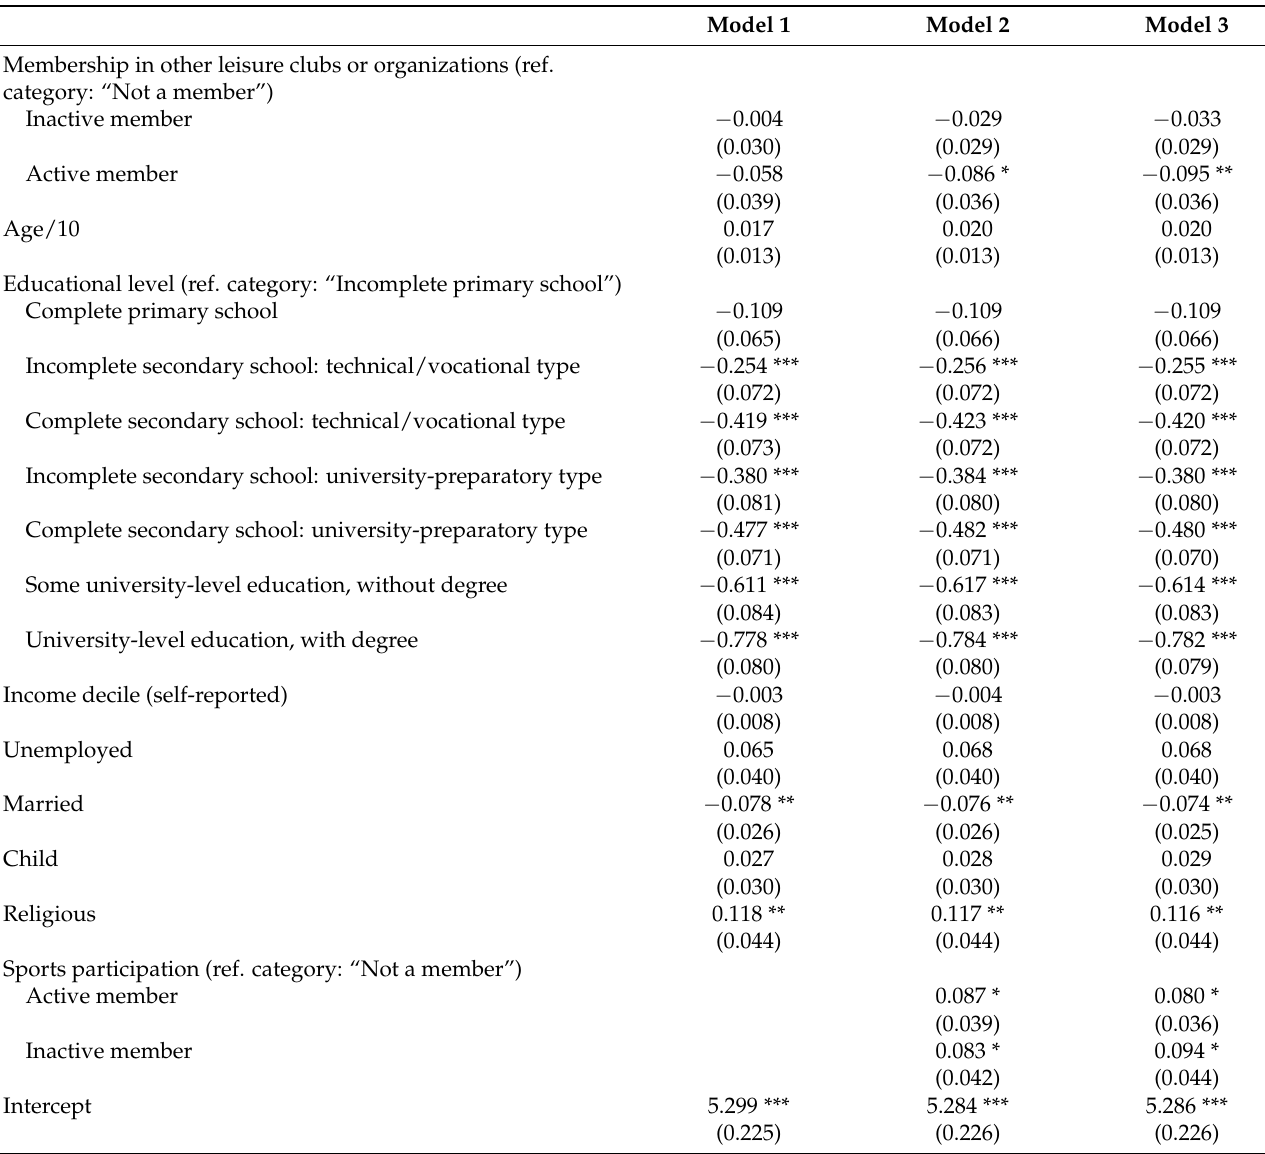
Table 3. The partial effects of sports participation and the other covariates on sexist gender ideologies. Random coefficient models based on male observations from 74 countries. Source: